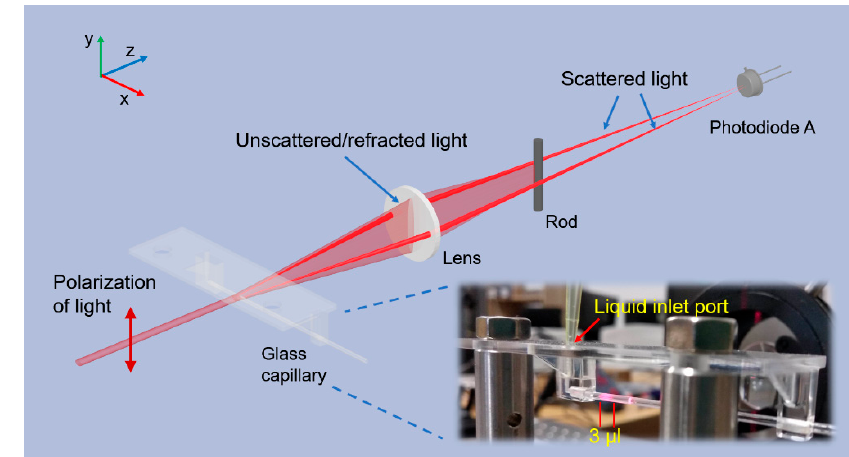
Figure 2. The 3D image of key components of nephelometric system. Only parts of scattered light are drawn. Inserted photograph shows the real image of glass capillary and its